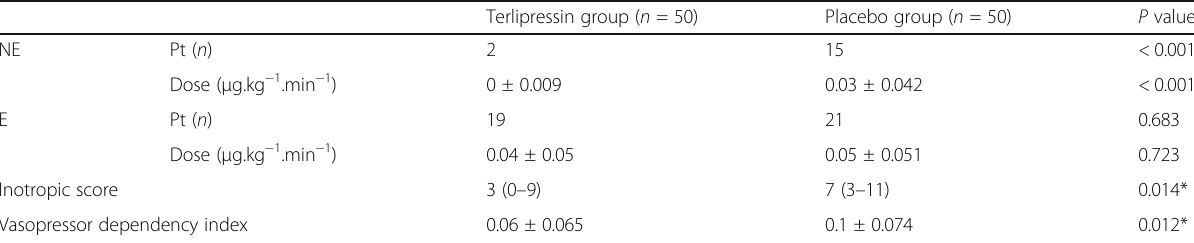
Table 3 Postoperative variables